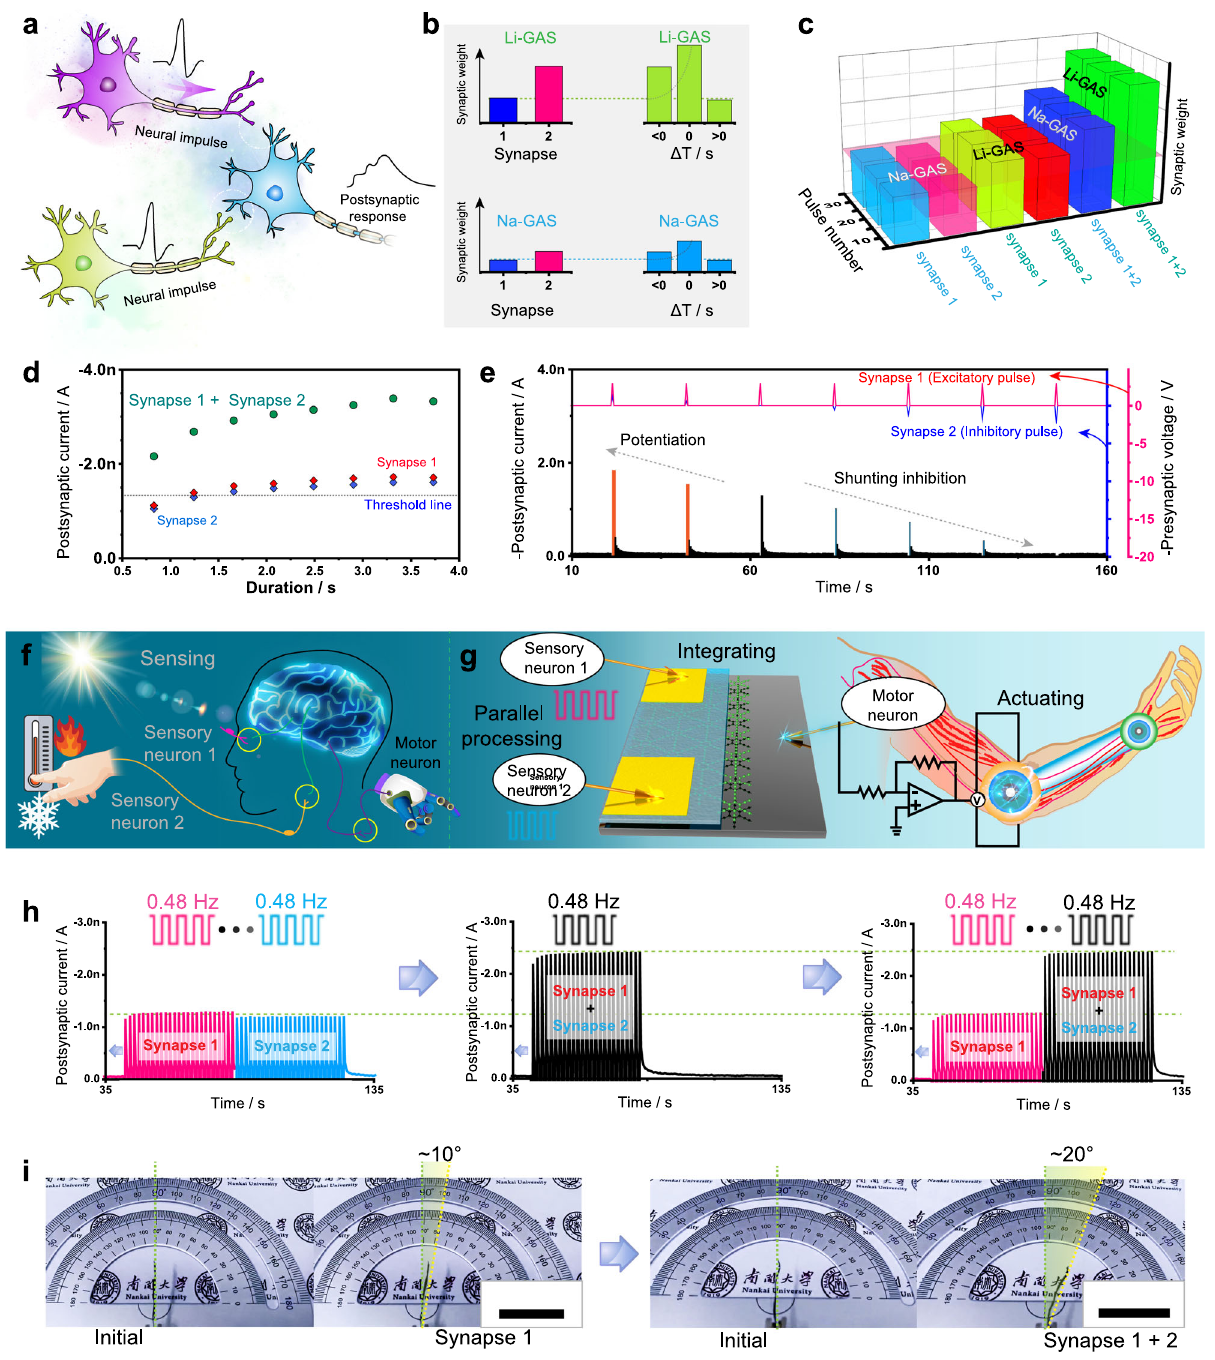
Fig. 5 Dendritic integration function in Li- and Na-GASs. a Schematic illustration of spatiotemporal neural networks in the GASs. b Synaptic weight (current) triggered by a single pulse and a pair of spatiotemporally correlated pulses in Li-GAS and Na-GAS. c Synaptic weight (current peak value) obtained under different numbers of applied pulses ( N = 10, 20, and 30) in Li-GAS and Na-GAS. d Postsynaptic current obtained under different durations of applied spikes in Li-GAS. e Postsynaptic currents triggered by a pair of presynaptic (excitatory and inhibitory) pulses for emulating the shunting inhibition function. Schematic illustration of f a biological sensorimotor nerve and g an arti fi cial efferent nerve, coupling GAS processing elements with arti fi cial muscles, to transduce signals from receptors to motor neurons. h Postsynaptic current triggered by two presynaptic inputs at 0.48 Hz from within the same time period to at different time periods. i Digital images of the actuator fl exion under 0.8 Hz pulse sequences for single and double synapses. The scale bar corresponds to 2